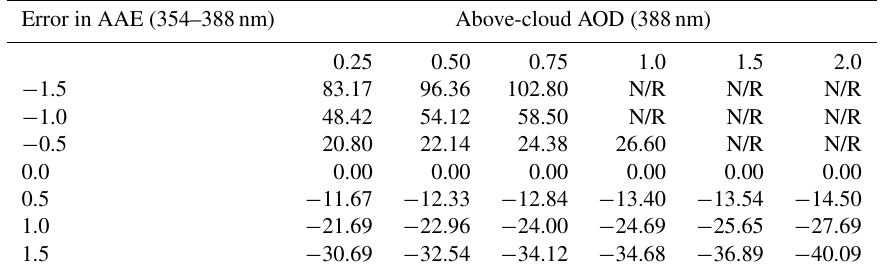
Table 5. Theoretical error (%) in ACAOD (388nm) due to the uncertainty in the assumption of aerosol absorption Ångström exponent (AAE). The reference value of AAE (354–388nm) assumed in the calculation was 2.65; the error in AAE (leftmost column) represents perturbation from this reference value. The cloud optical depth underneath the aerosol layer was assumed to be 10. Simulations marked with N/R (not retrieved) represent the retrieval failure due to the out-of-domain issue.